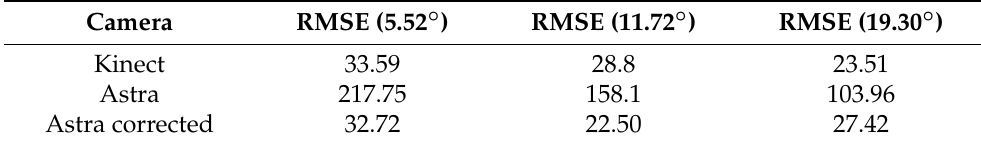
Table 2. RMSE values obtained for the Kinect and the Orbbec Astra sensor in mm before and after applying the proposed thermal compensation method and considering captures at three different